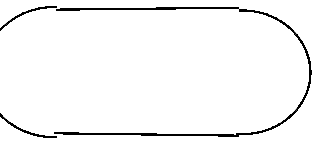
Figure 20. Flow chart of precise selection.